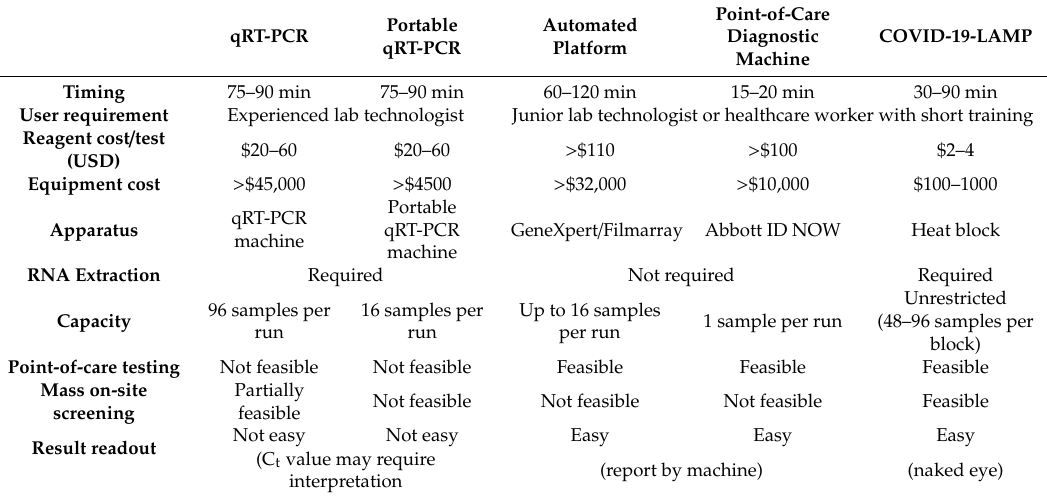
Table 1. Comparison of existing COVID-19 molecular diagnostic tests with COVID-19-LAMP.